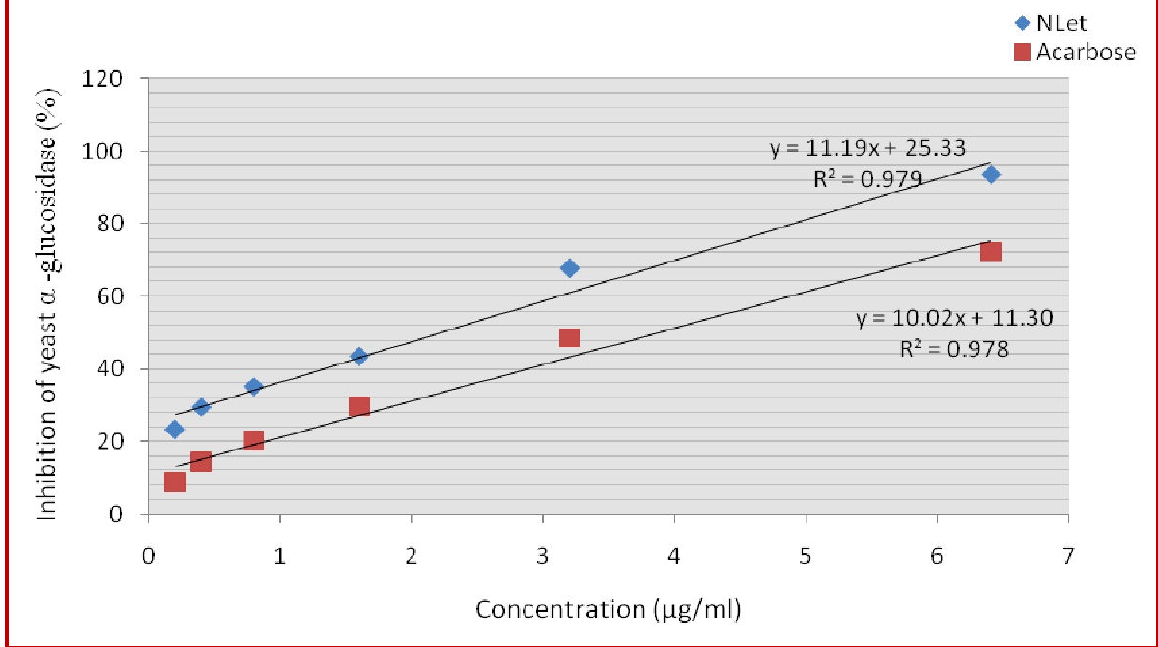
Figure 1: Inhibitory effect of N. laevis extract on baker’s yeast α - glucosidase Values represent mean ± SEM of three replicates